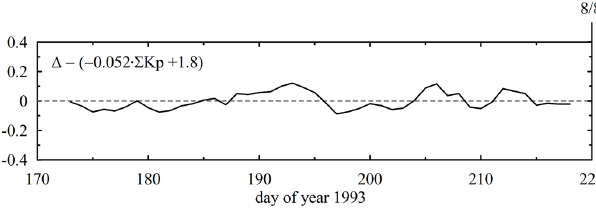
Fig. 2. Residual time series of the linear relationship between the 9-day running averages of 1 and 6K p during the period of time before the Guam